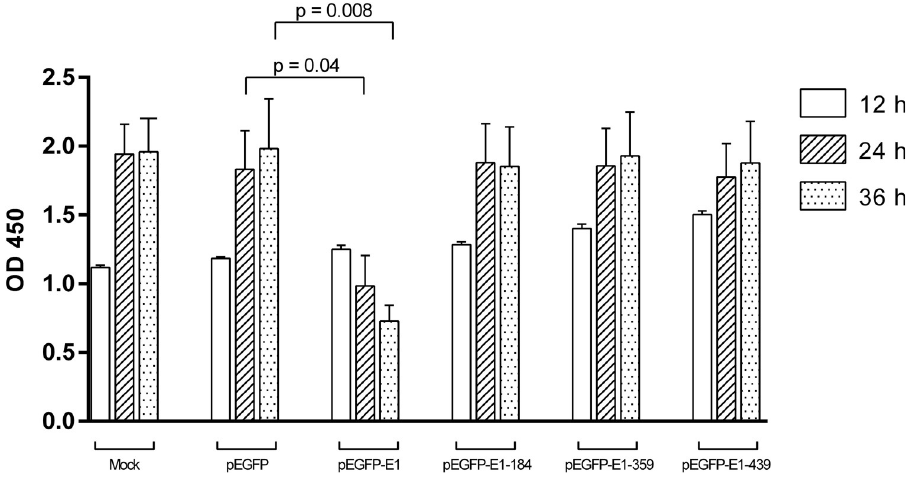
Fig 5. Cell proliferation was significantly decreased in full-length HPV16 E1 (pEGFP-E1) transfected cells. Cell proliferation of pEGFP, vector control, full-length HPV16 E1 (pEGFP-E1) and truncated forms of HPV16 E1 (pEGFP-E1-184, pEGFP-E1-359, and pEGFP-E1-439).